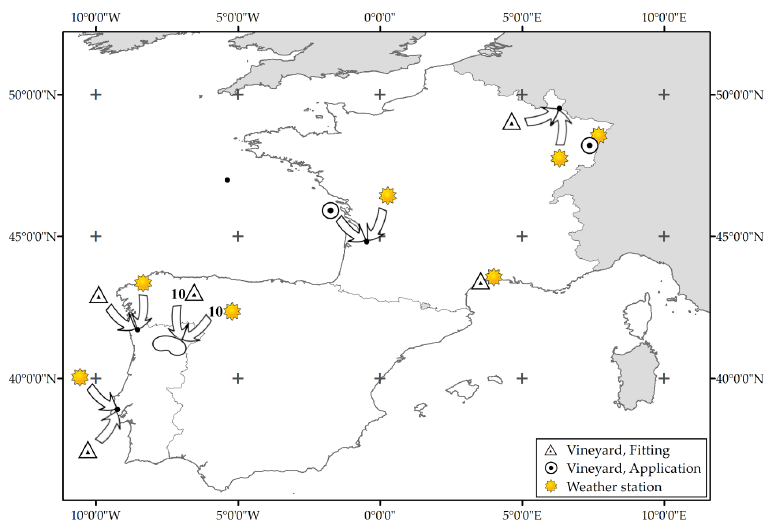
Figure 1. Map of the vineyards and weather stations situated in three European countries (Luxembourg, France and Portugal). The vineyards are displayed with triangles and points in relation to the use of phenological data for model fitting or application. The arrows indicate that both vineyards and weather stations are located in the same site. 10 weather stations and 10 vineyards are situated in Douro valley